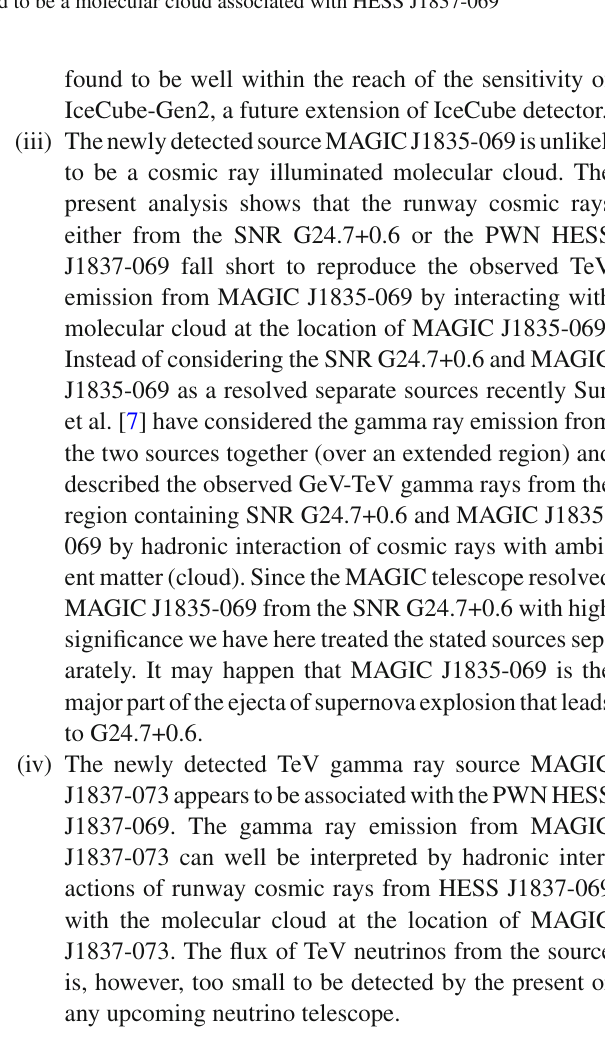
Fig. 6 Same as in Fig. 4 but for MAGIC J1837-073 which is investigated to be a molecular cloud associated with HESS